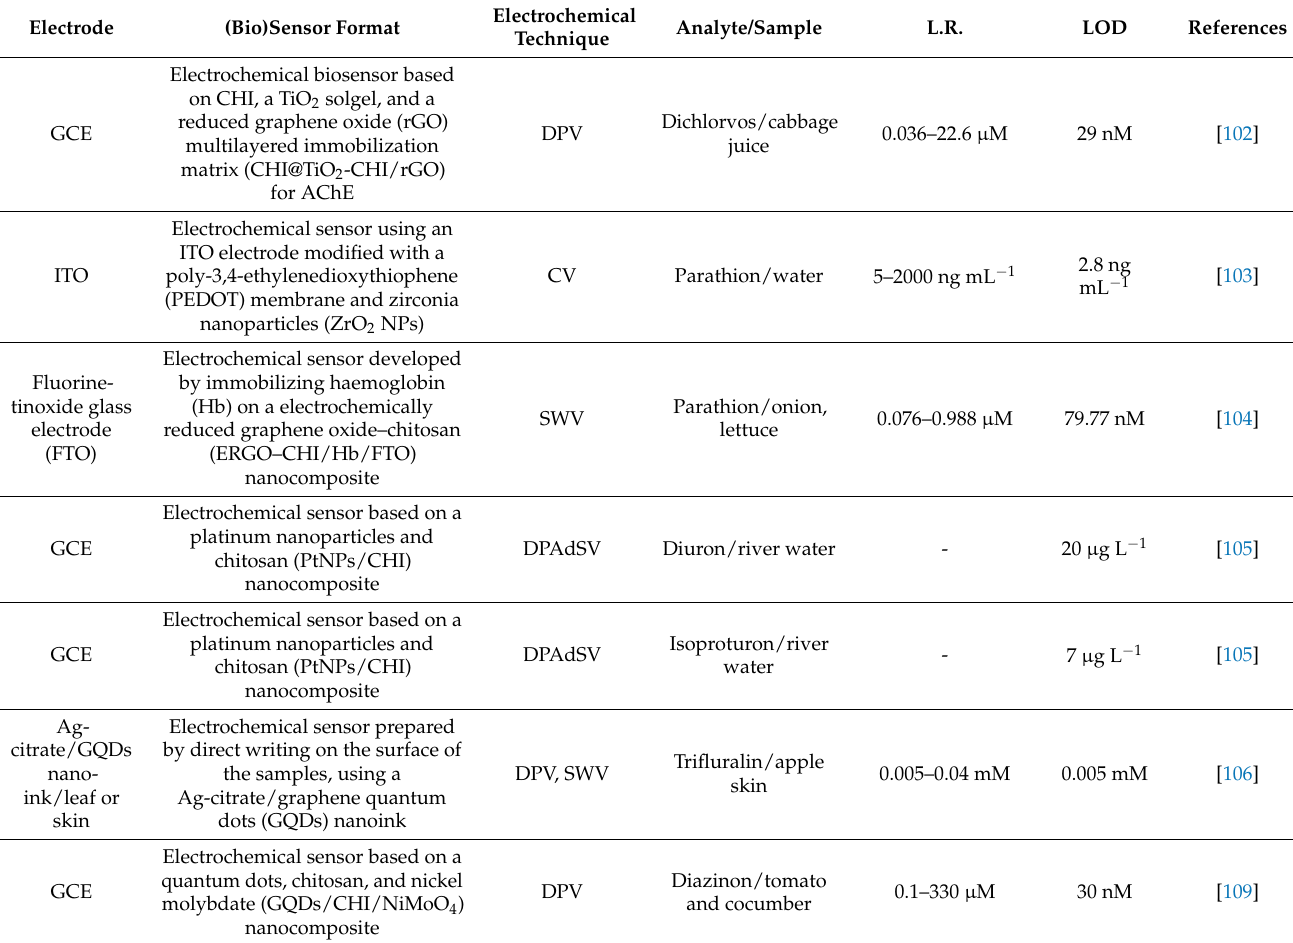
Table 5. Recent examples of CHI-based electrochemical (bio)sensors for pesticides detection.